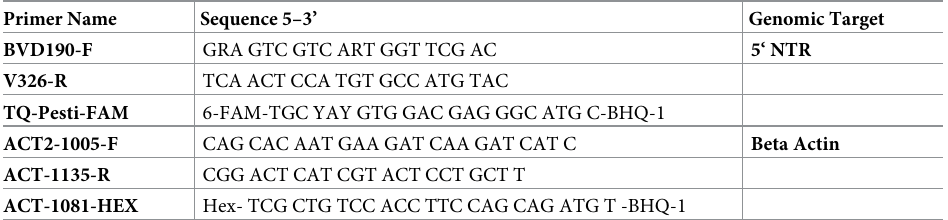
Table 3. Real-time quantitative PCR